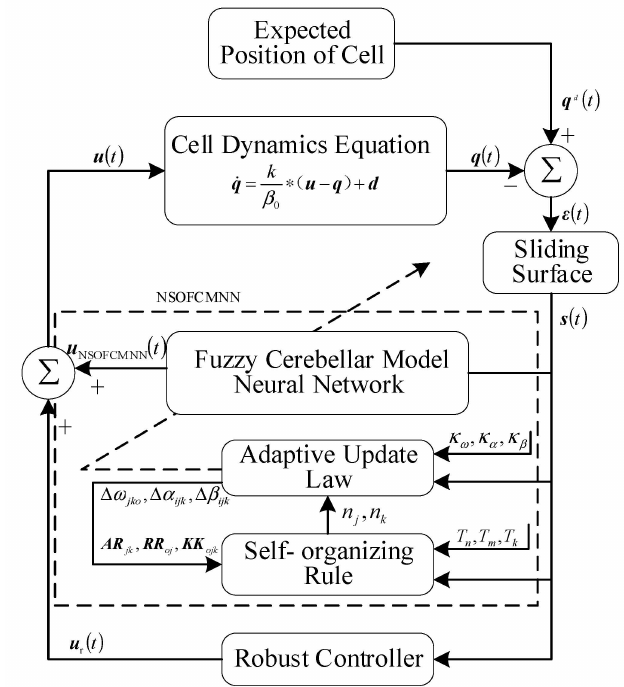
Figure 4. Structure of the cell manipulation control